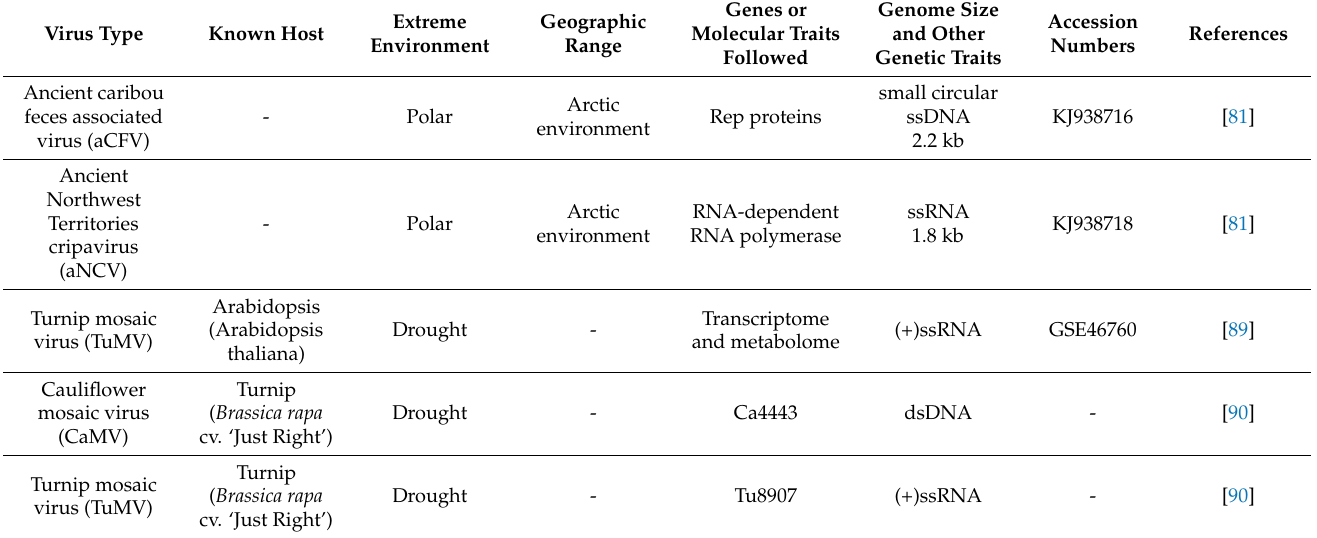
Table 5. Virus in extremophile